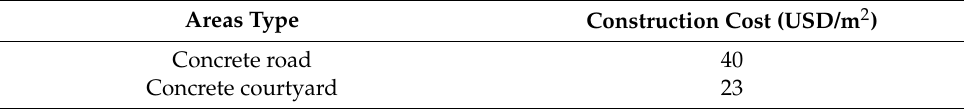
(Table 9) was examined by the Valuers Association of Thailand (http://www.vat.or.th; accessed on 15 January 2021). Table 9. The structure of infrastructure construction price